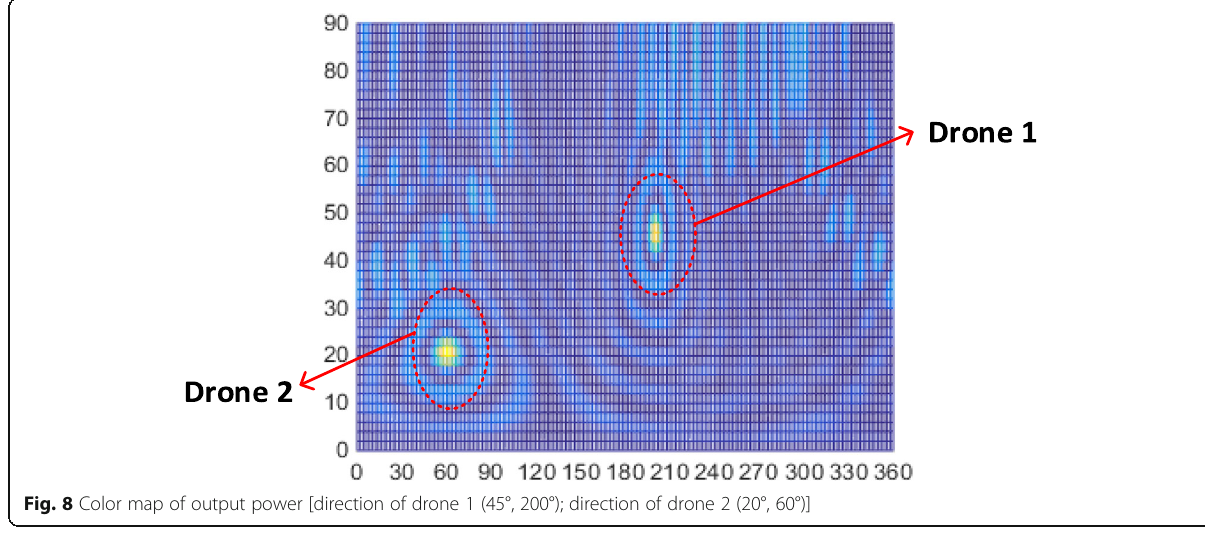
Fig. 8 Color map of output power [direction of drone 1 (45°, 200°); direction of drone 2 (20°,